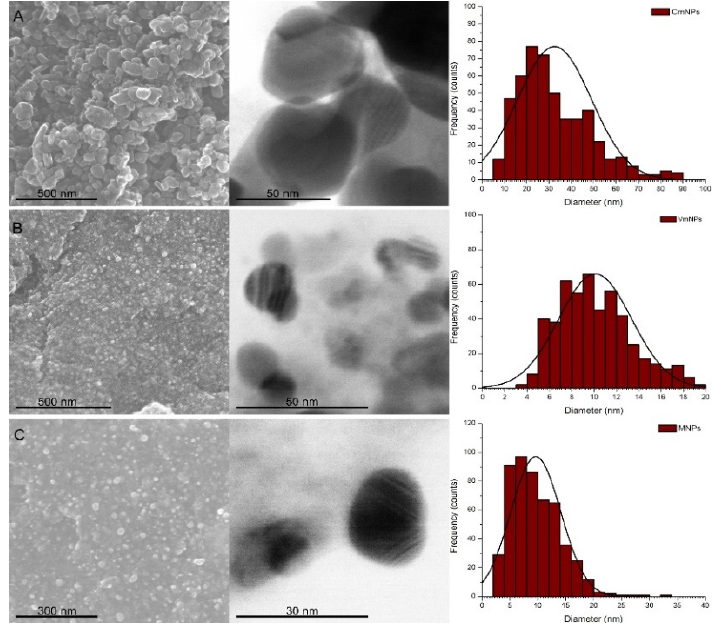
Figure 2. SEM and TEM micrographs showing the morphology of nanoparticles and the graphs with Gaussian fit of the size distribution; A : CmNPs, B : VmNPs, C : MNPs.